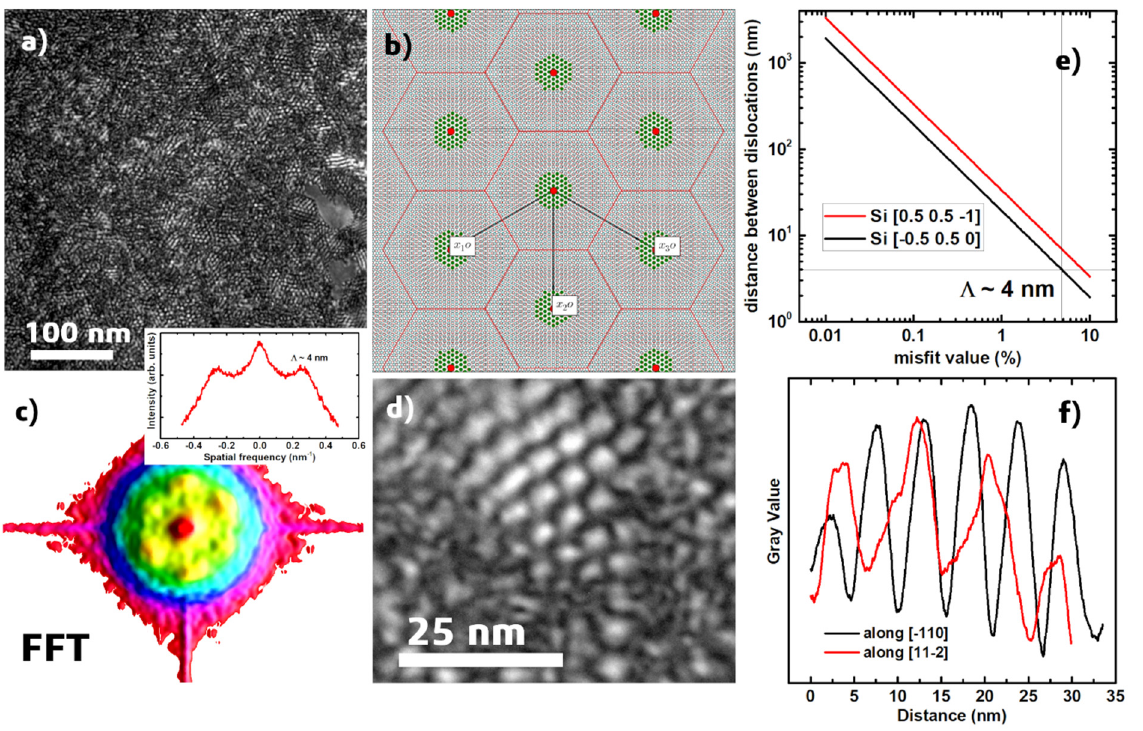
Figure 9. ( a ) A TEM plan-view image of one layer of Fe 3+ x Si 1 − x grown on Si(111) (over-focus mode); ( b ) 2D O-lattice formed by overlapping two lattices, lattice points of which are represented by small, red circles (Si) and cyan circles (Fe 3 Si), respectively. Each O-point (large circle) is at the centre of an O-cell (O-cell walls—solid lines), and near coincidence sites are depicted with green-filled circles; ( c ) FFT image in a 3D perspective view of Figure 9a. The inset depicts a line cut over the FFT image. ( d ) Magnified view of the structural motif of the dislocation lattice; ( e ) dependence of distance between dislocation along [ − 110] and [11 − 2] directions on misfit value for silicon; and ( f ) intensity distribution along two directions of the structural motif depicted on Figure 9d.